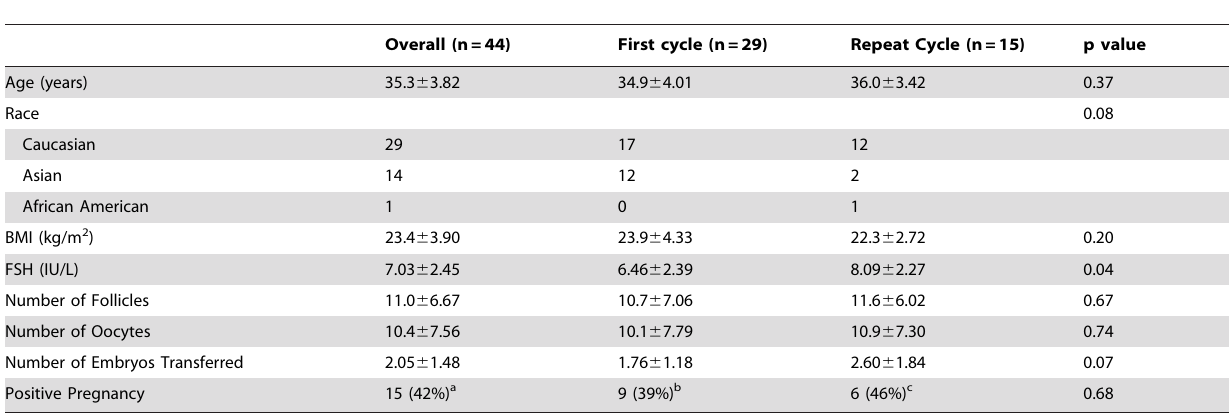
Table 1. Demographic and clinical characteristics of all participants.